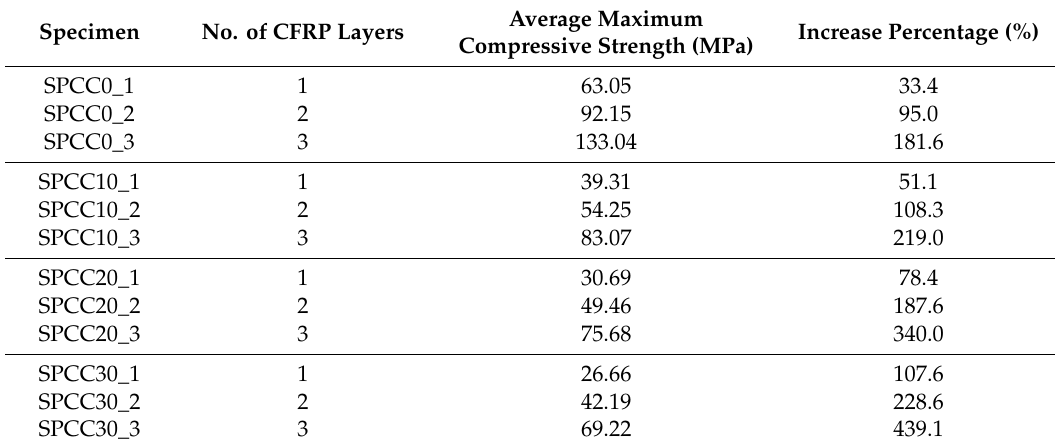
Table 10. Compressive strength test results for the SPCC specimens.